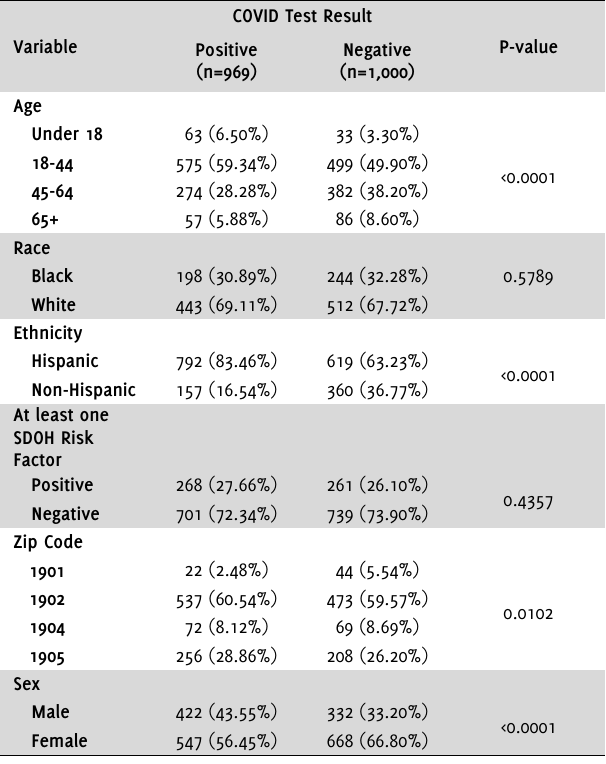
Table 1. Association Between Demographics and COVID-19